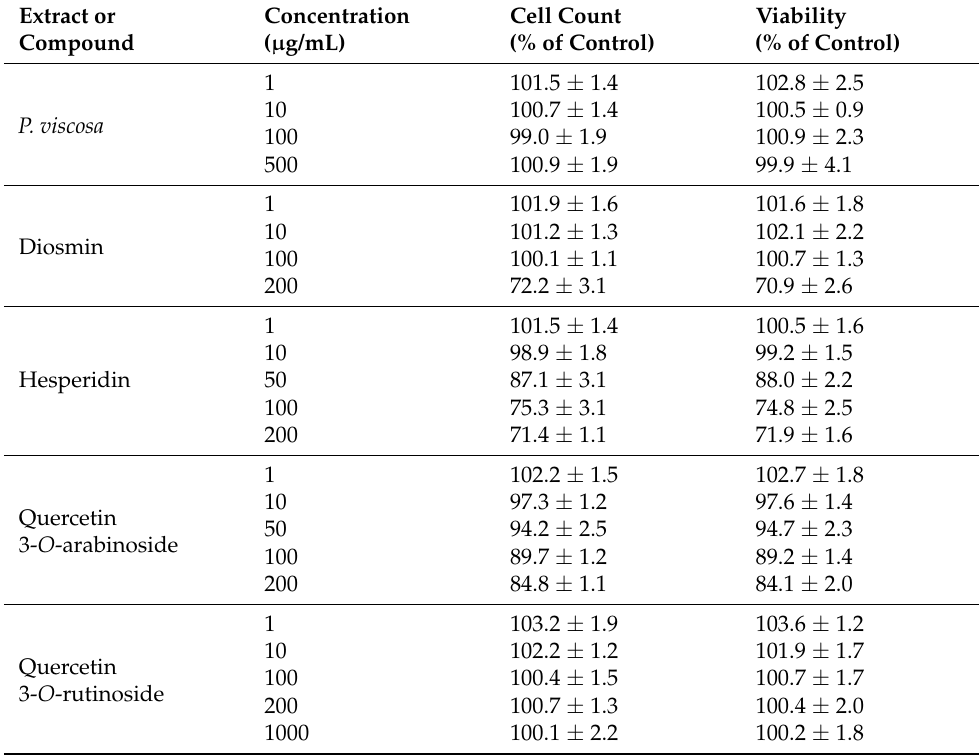
Table 3. Toxicity test of the extract and phytochemicals against eukaryotic cells. Extract